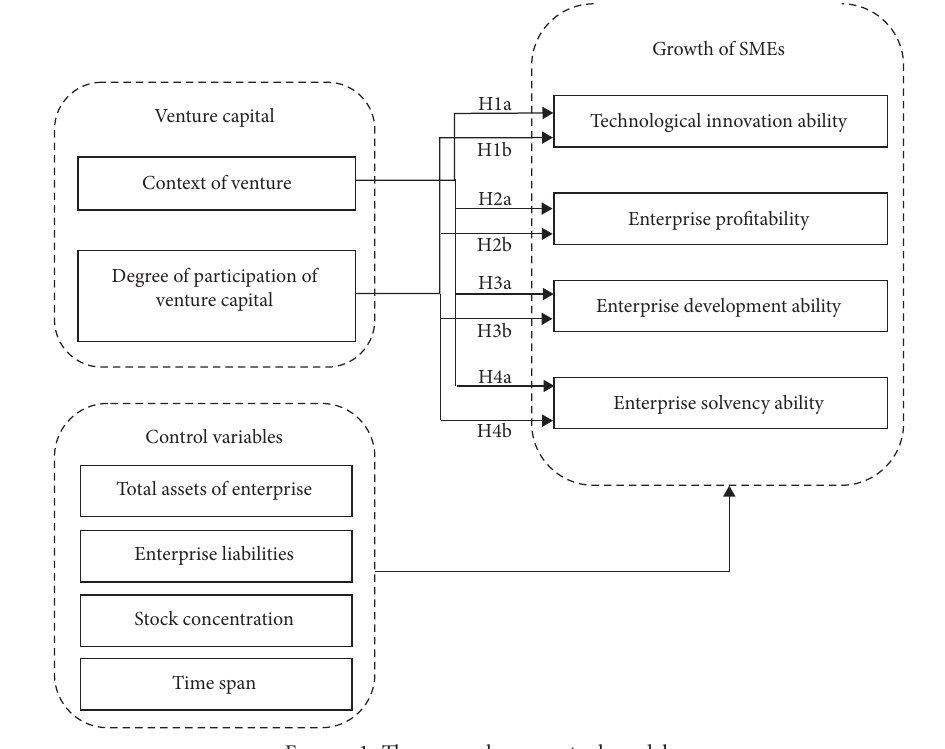
Figure 1: The research conceptual Table 1: Description of variables and values assigned.